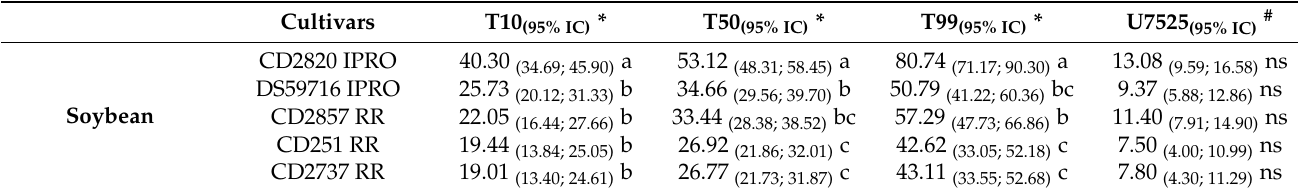
Table 7. Germination times and uniformity for corn and soybean hybrids and/or